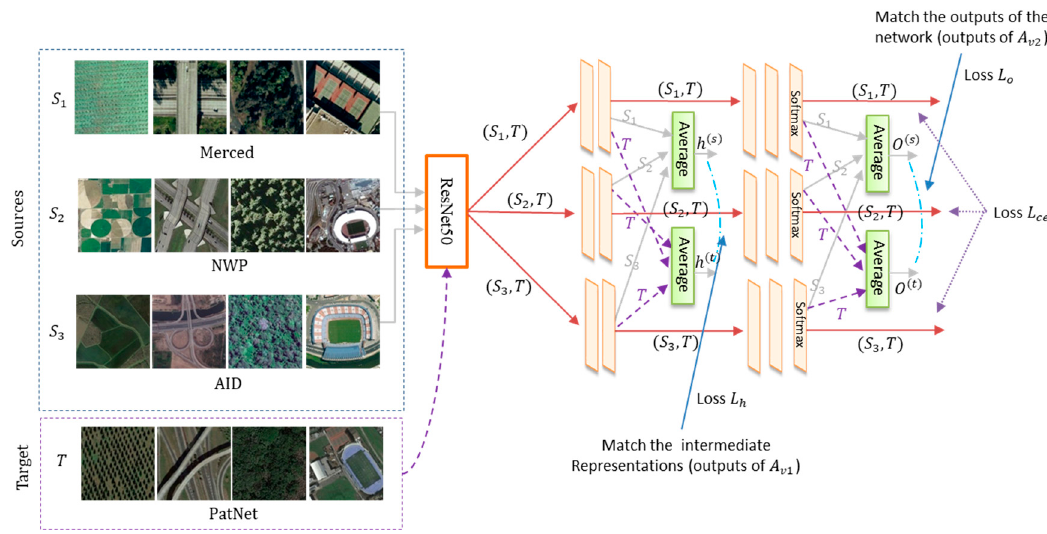
Figure 1. Proposed MB-Net architecture: Pre-trained convolutional neural networks (CNN) coupled with additional branches, where each branch is related to a specific source dataset S k